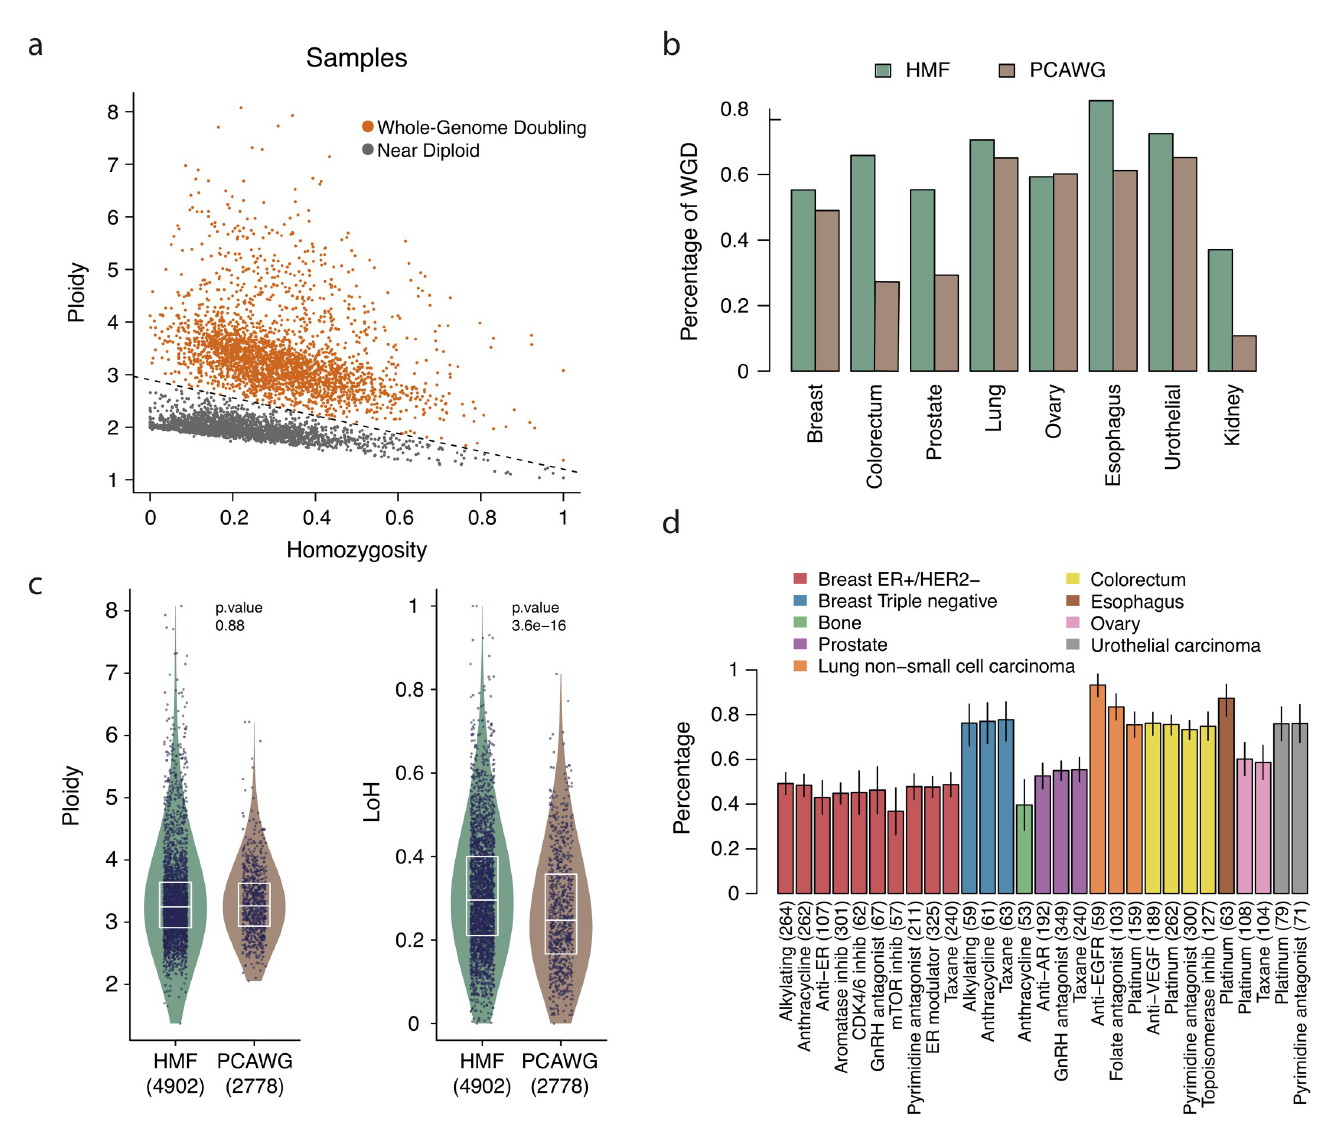
Fig 1. Features of WGD tumors exposed and unexposed to anticancer therapies. a) Tumors across one primary (PCAWG) and one metastatic (HMF) cohort may be classified as WGD and non WGD (or nearly diploid) based on their ploidy and level of heterozygosity. b) Different fractions of WGD tumors are observed across different types of cancer in primary and metastatic cohorts. c) Distribution of ploidy (left) and fraction of the genome with LoH (right) of WGD tumors across primary and metastatic cohorts. The boxes inside the violin plots delimit the first, second and third quartiles of the distribution. All tumors in each group are represented as dots. P-values were derived from a two-tailed Wilcoxon-Mann-Whitney test. d) Fraction of WGD metastatic tumors among those exposed to different therapies in the HMF cohort. The number of tumors exposed to each treatment appear in parentheses. The bars represent the mean fraction for tumors in each group (group size below each bar) and the short vertical line, the standard